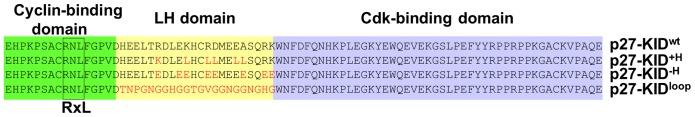
Sequences of p27-KID LH sub-domain variants used in this study.The mutated residues within sub-domain LH are colored red. RxL motif residues are boxed.